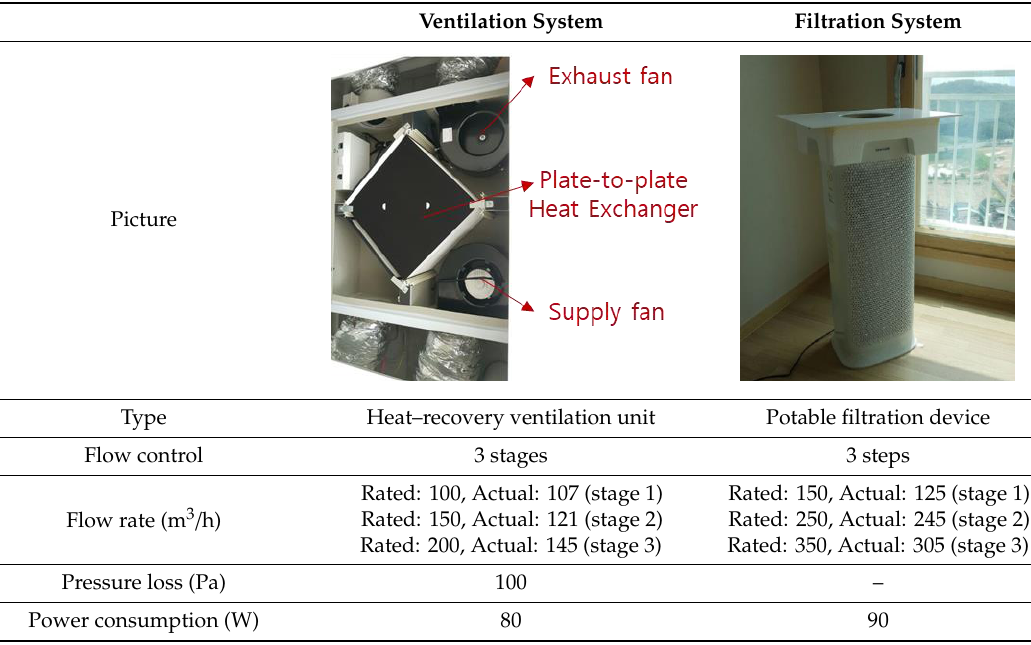
Table 2. Description of ventilation and filtration system.